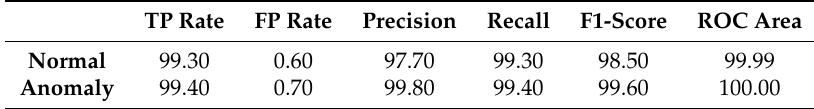
Table 20. Classification report for Bagging